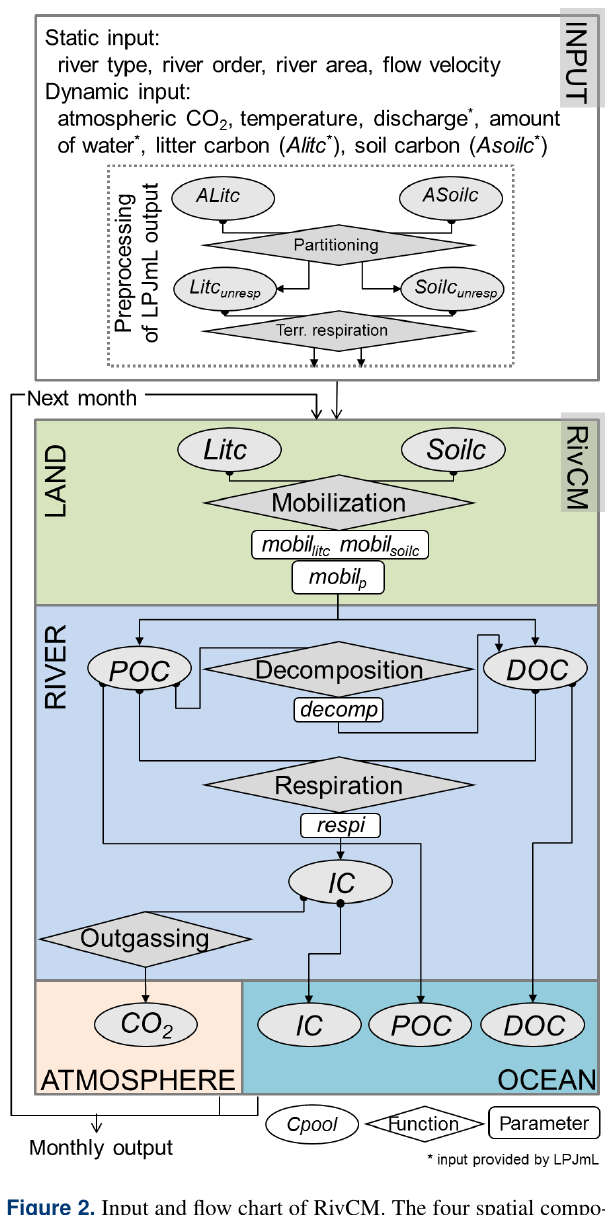
Figure 2. Input and flow chart of RivCM. The four spatial compo- nents “LAND”, “RIVER”, “ATMOSPHERE” and “OCEAN” are connected by the exchange of carbon between different carbon pools (ovals). The carbon pools are transformed through the most relevant processes (diamonds) with specific rates and ratios (rectan- gles). After the initialization of the input, calculations are conducted on a monthly basis. Litc: carbon in litter; Soilc: carbon in soil; POC: particulate organic carbon; DOC: dissolved organic carbon; IC: in- organic